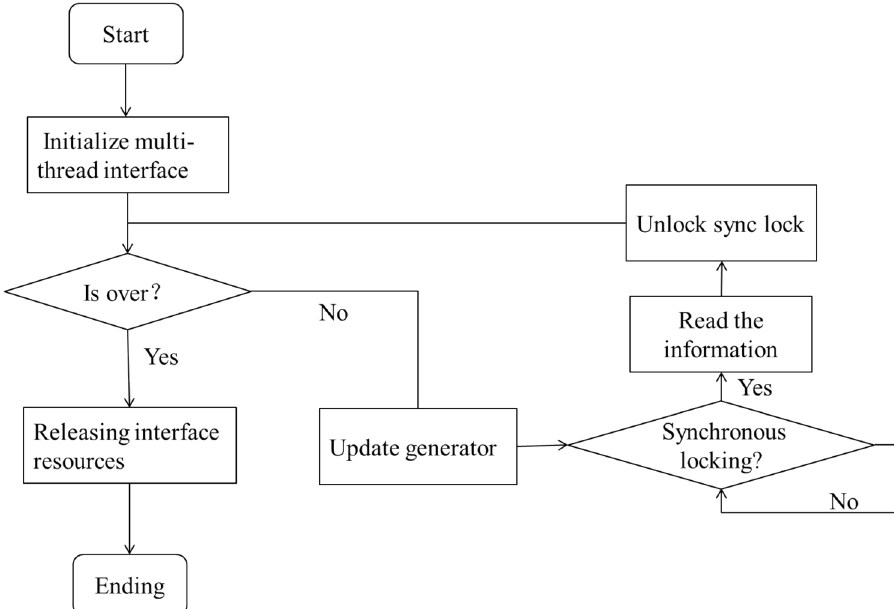
Figure 10. Select the left menu.